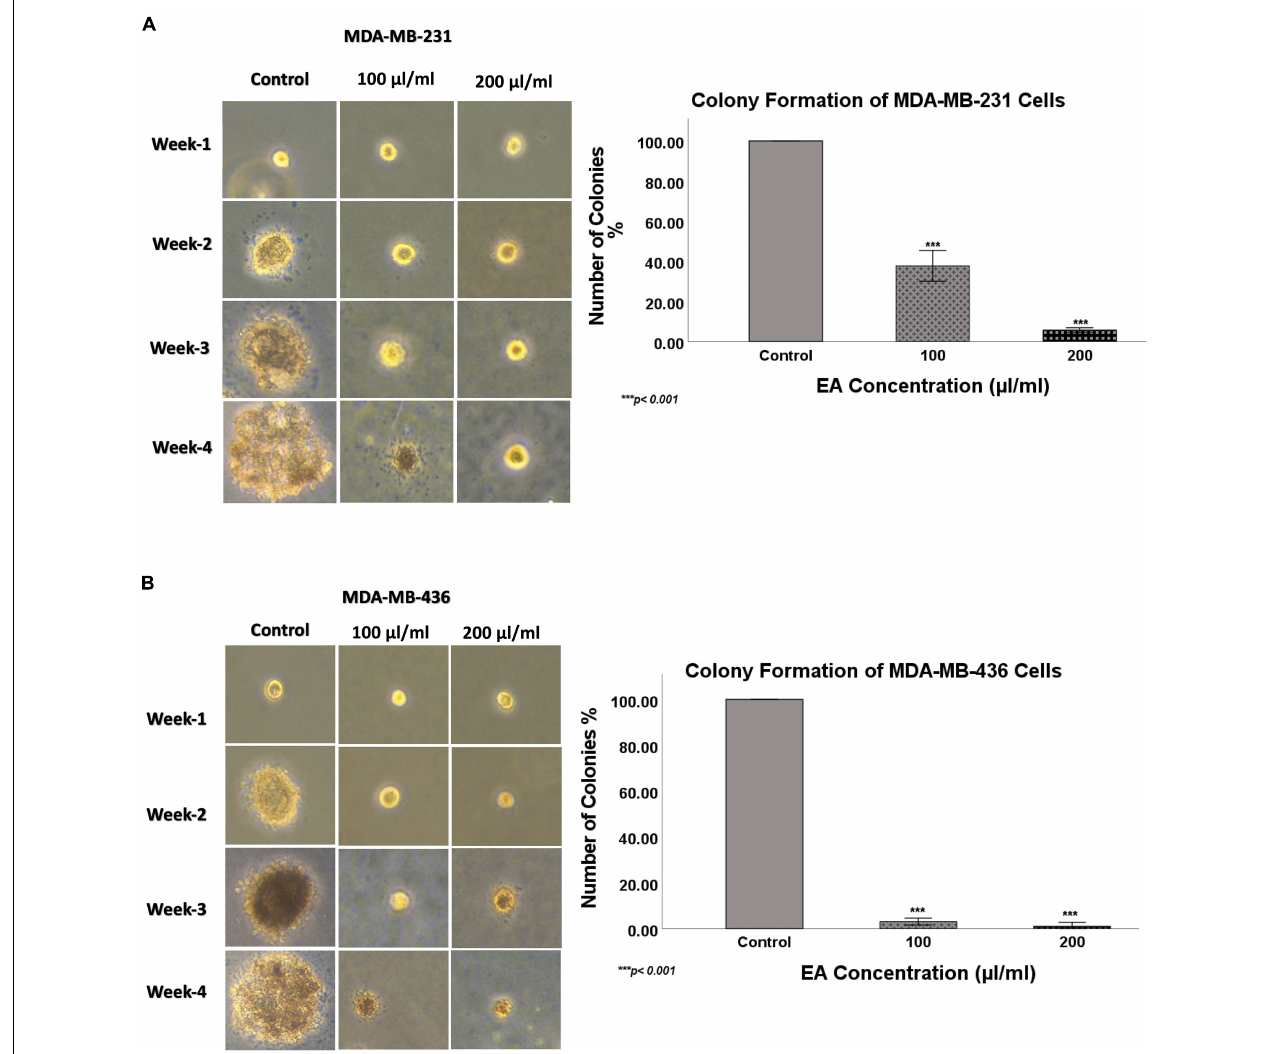
FIGURE 5 | The effect of EA extract on colony formation, in soft agar, in human TNBC cell lines (A) MDA-MB-231 and (B) MDA-MB-436. EA extract inhibits colony formation of MDA-MB-231 and MDA-MB-436, in comparison with their matched control cells. Images were taken at 10x magnification. The colonies were counted manually and expressed as percentage of treatment relative to the control (mean ± SEM; n = 3). *** p <